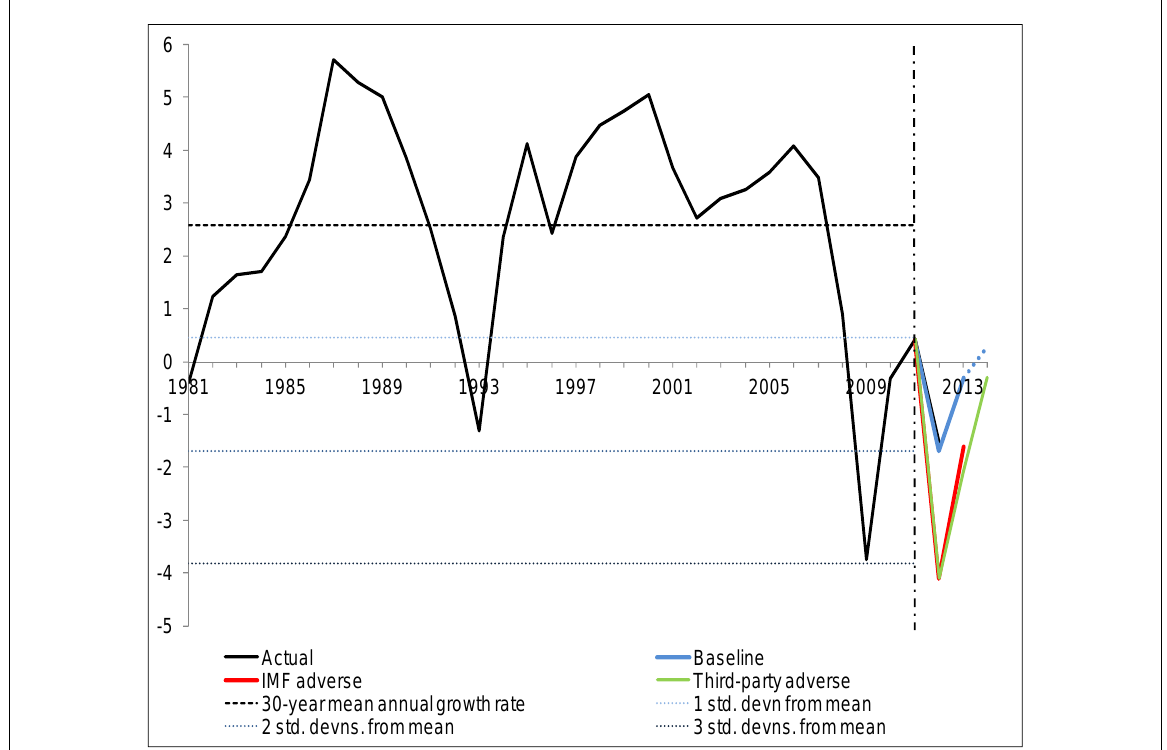
Box Figure 1. Spain: 30-year Average Annual Growth Rate and Stress Test Scenarios (In